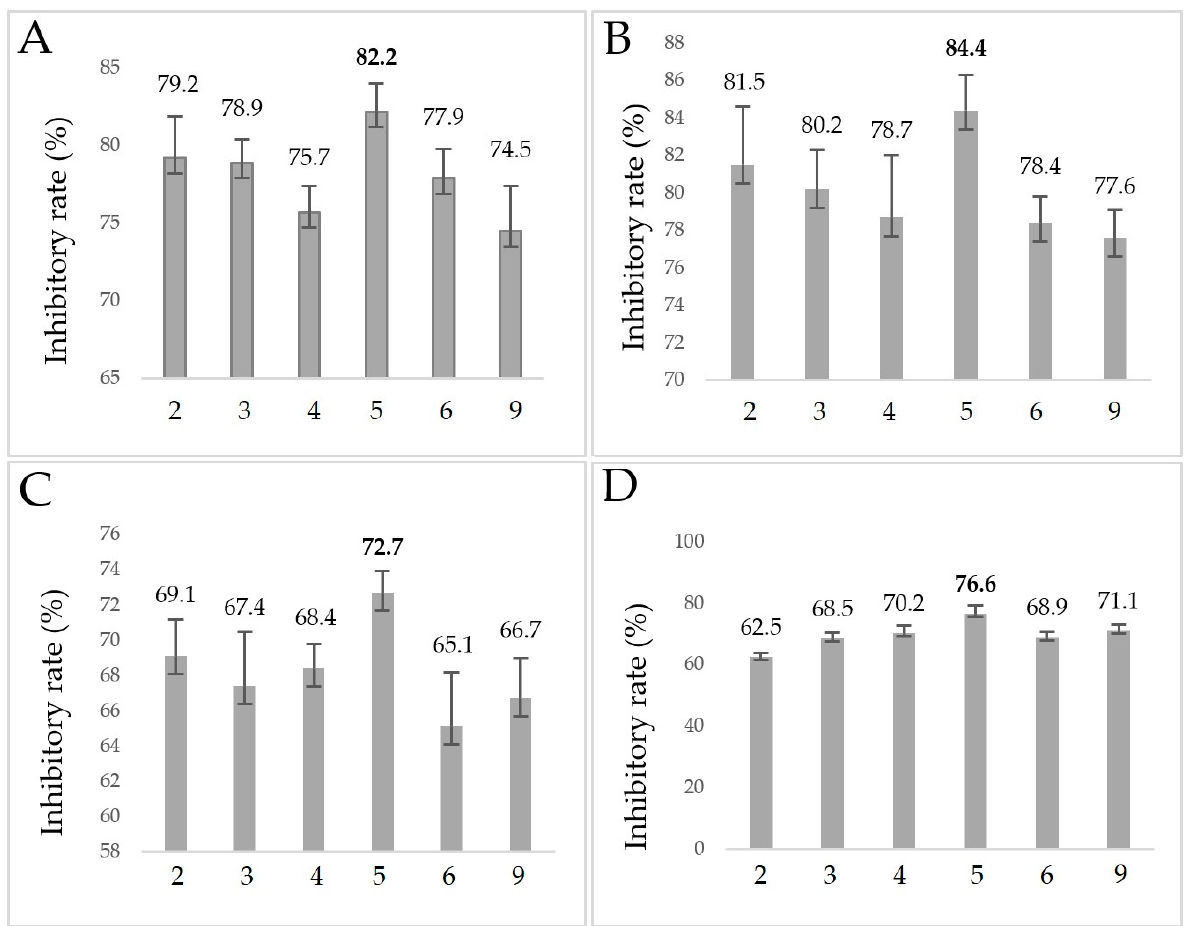
Figure 2. Inhibitory rates of essential oils in the biofilm assay. O. vulgare “Hirtum” ( 2 ), O. vulgare “Margarita” ( 3 ), O. vulgare “Hot & Spicy” ( 4 ), O. majorana ( 5 ), O. syriacum (I) ( 6 ), O. syriacum (II) ( 9 ); ( A ): H. influenzae , ( B ): H. parainfluenzae , ( C ): P. aeruginosa , ( D ): MRSA; Inhibitory rate = (1–S/C) × 100%, where C and S were de fi ned as the average absorbance of control and sample groups, respectively.